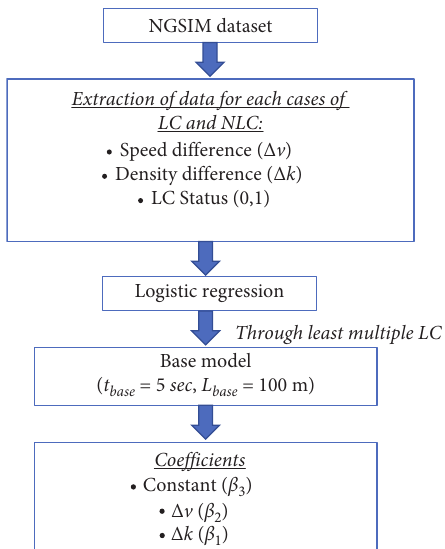
Figure 3: Steps to identify the coefficients of the parameters for the base